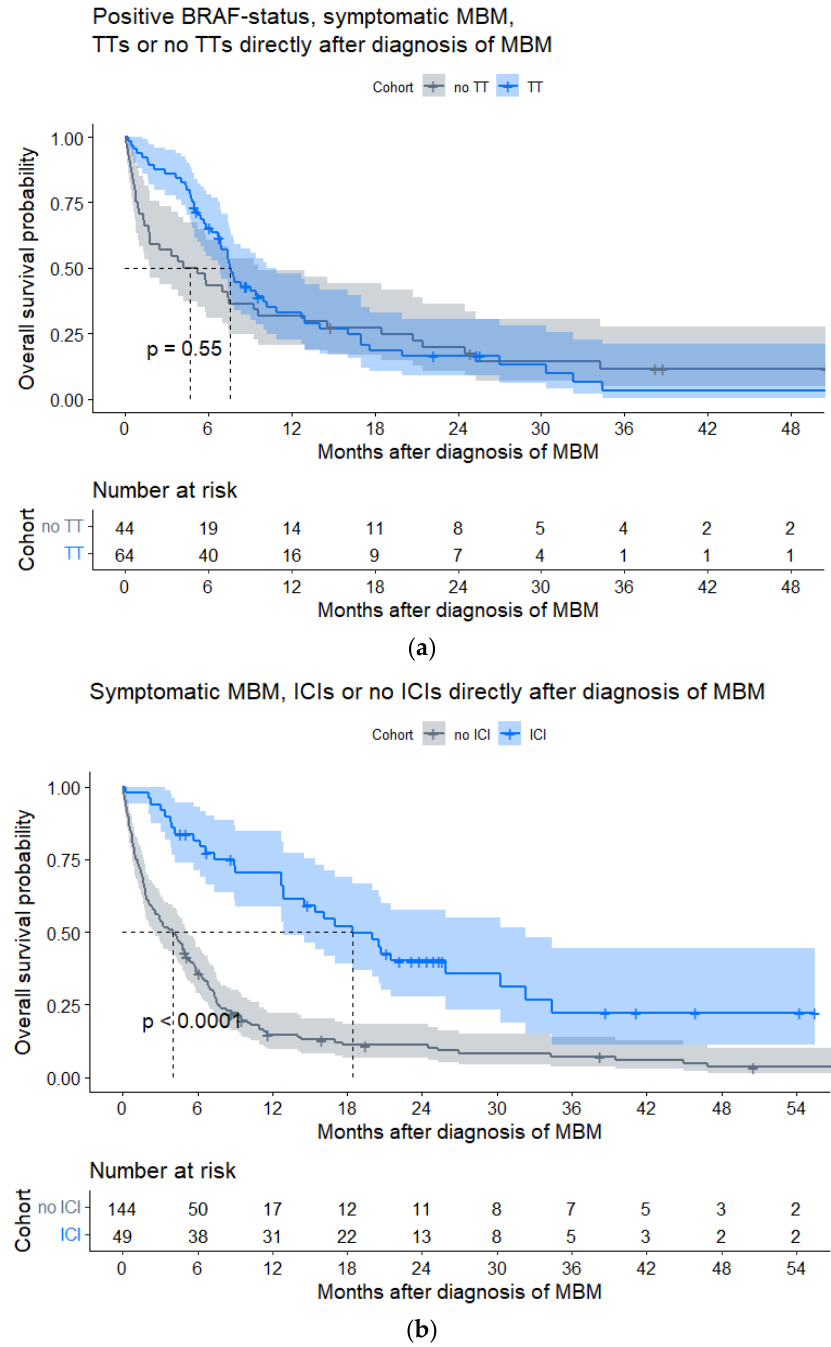
Figure A5. Kaplan – Meier curves in symptomatic patients with melanoma brain metastasis (MBM) in the post-2015 cohort ( n = 193) and systemic treatments given directly after diagnosis of MBM. ( a ) targeted therapies (TTs) or no TTs directly after diagnosis of MBM in patients with a positive BRAF V600E+/K-status ( n = 108). ( b ) immune checkpoint inhibitors (ICIs) or no ICIs directly after diagnosis of MBM. Table A6. Median overall survival of the melanoma-molGPA classes of patients with melanoma brain metastasis (MBM) in the post-2015 cohort with available model input parameters ( n = 268).